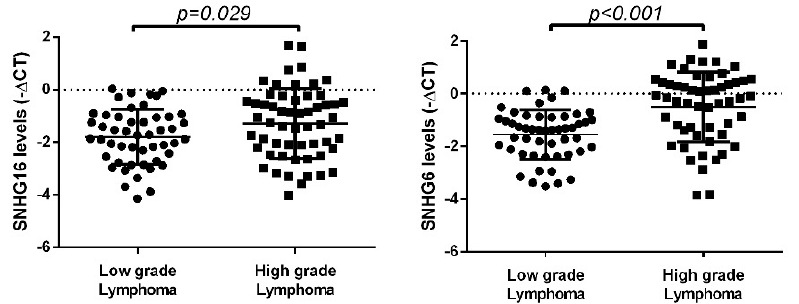
Figure 6. Expression levels of SNHG16 and SNHG6 in plasma samples of NHL patient groups according to lymphoma grade. SNHG16 and SNHG6 presented higher plasma levels in patients diagnosed with high-grade lymphoma compared to low-grade lymphoma ( p = 0.029 and p < 0.001, respectively). The graphics represent the − ∆ CT of miRNA expression normalized to the endogenous control (mean ± SD).